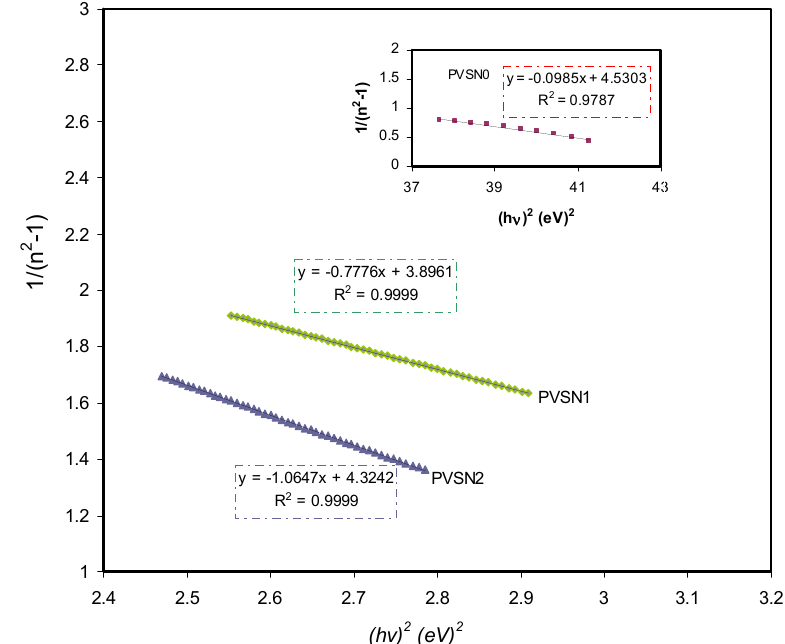
Figure 9. 1/(n 2 − 1)against ( h υ ) 2 for PVA and loaded Figure 9 . 1/(n 2 − 1)against (h υ ) 2 for PVA and loaded films. Table 2. E o and E d for the PVA and loaded films.